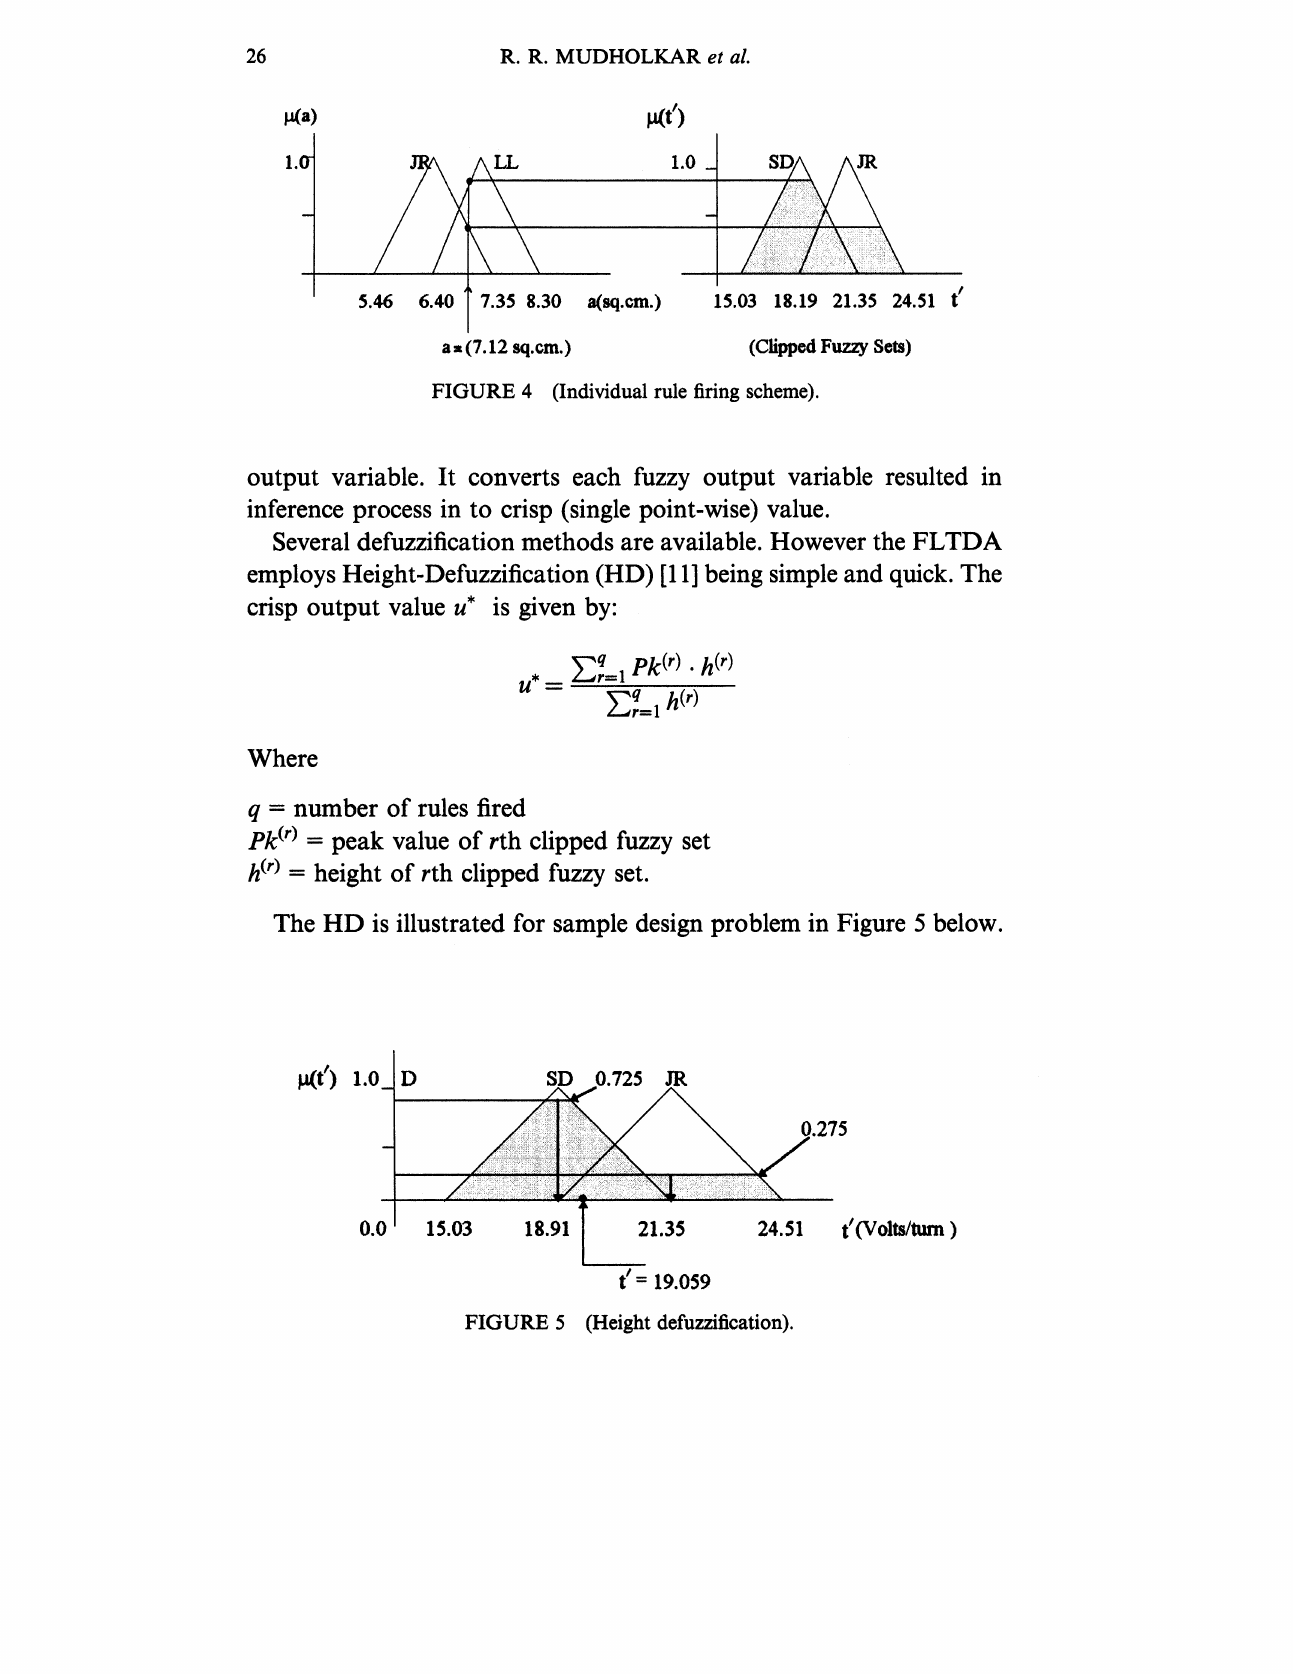
FIGURE 5 (Height